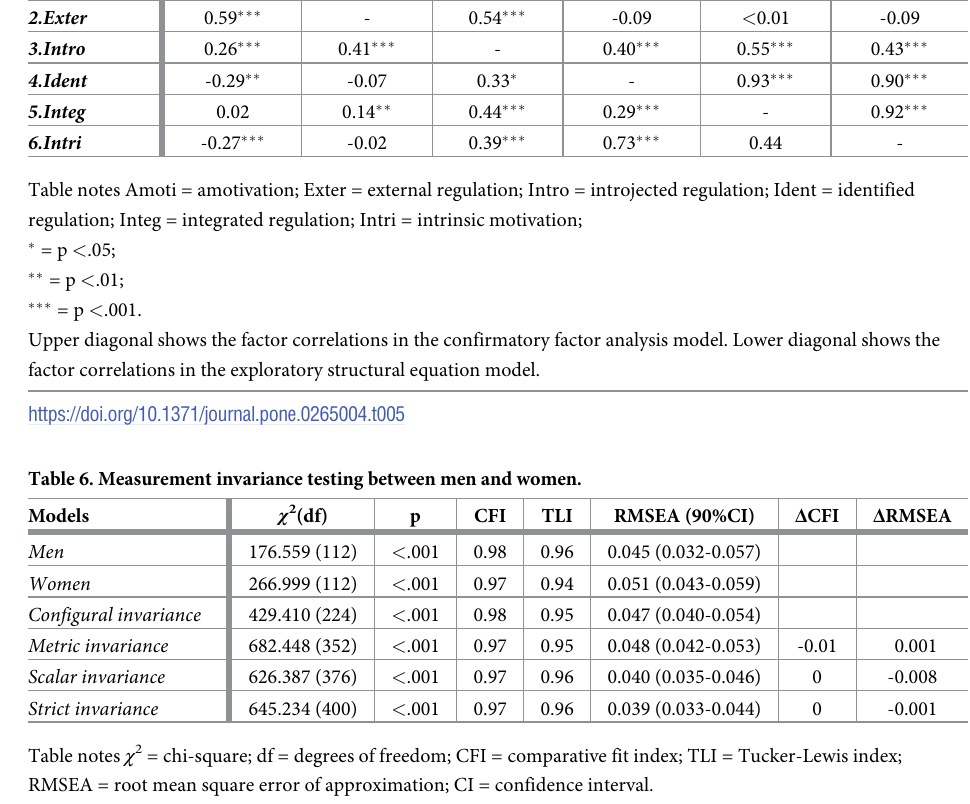
Table notes χ 2 = chi-square; df = degrees of freedom; CFI = comparative fit index; TLI = Tucker-Lewis index; RMSEA = root mean square error of approximation; CI = confidence interval.